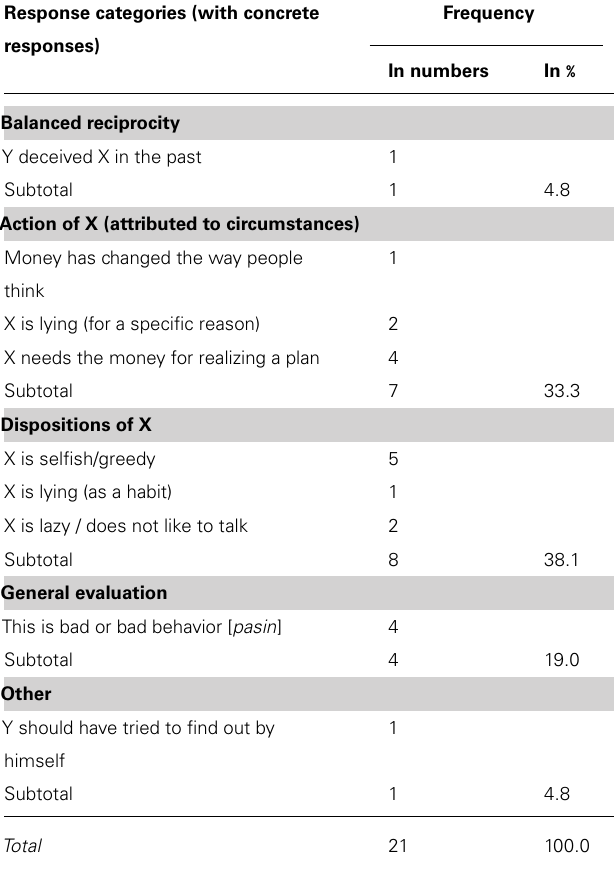
Table 2 | Explanations for social interaction: